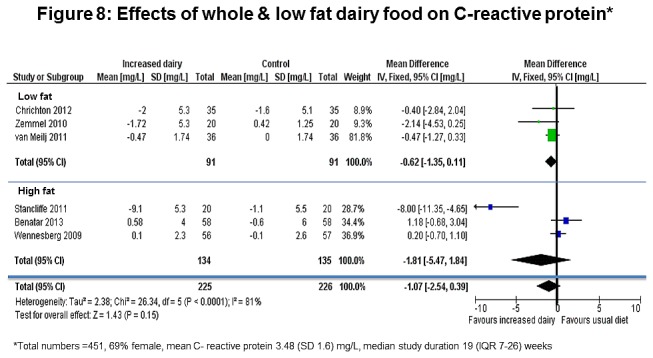
Effects of whole & low fat dairy food on C-reactive protein.